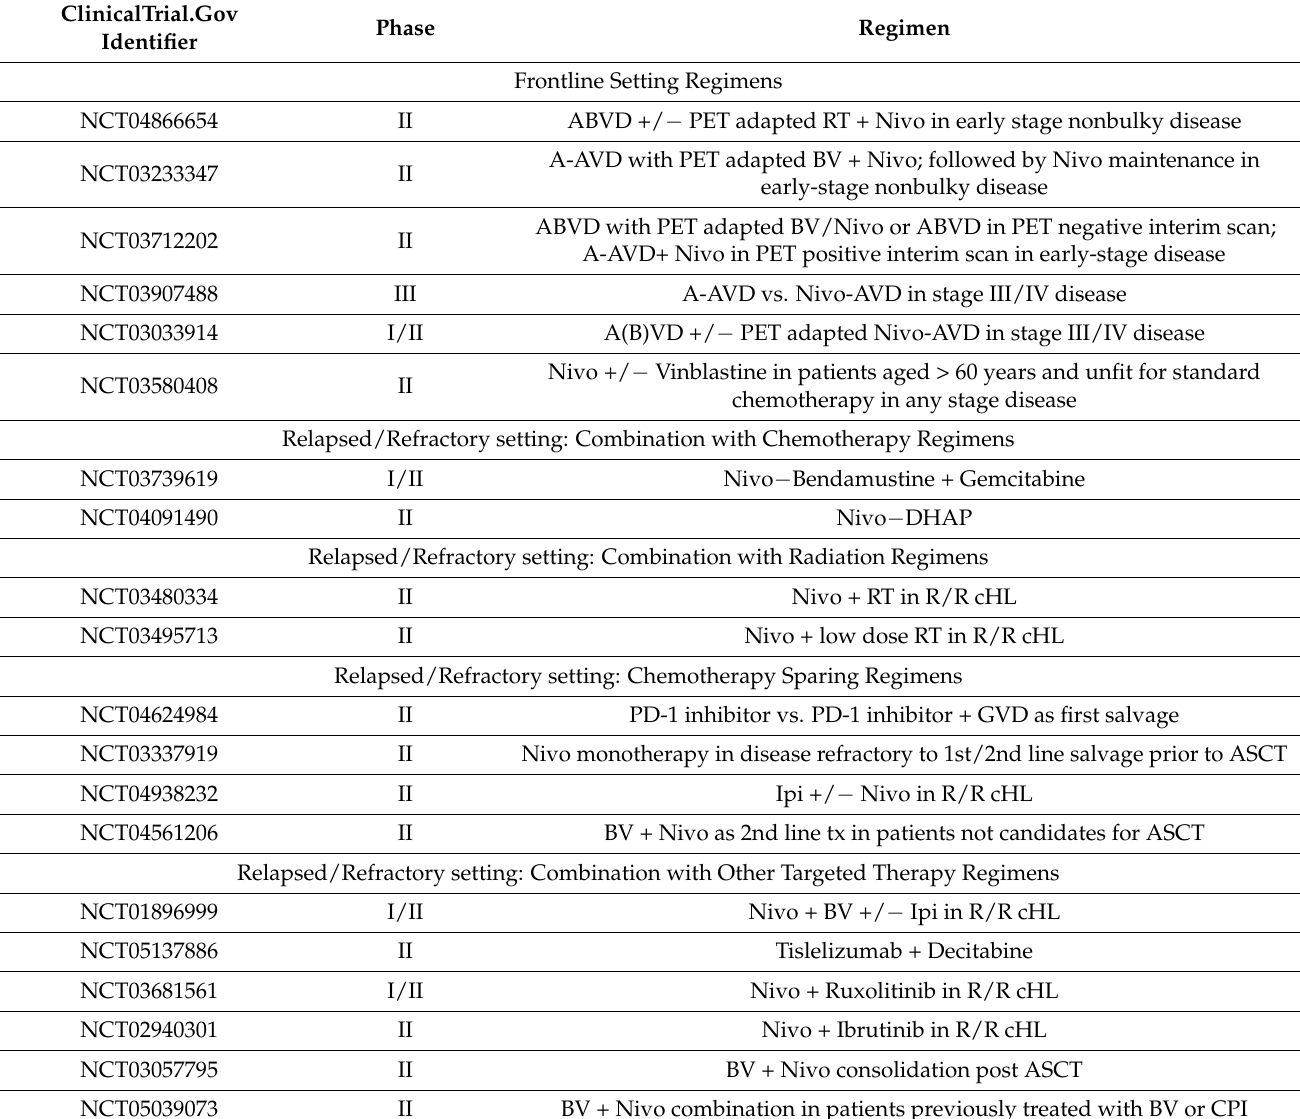
Table 2. Phase II/III Pipeline Studies Evaluating Anti-PD1 mAb Therapies in Hodgkin’s Lymphoma.